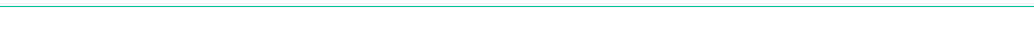
Fig. 4. The single most parsimonious tree generated from maximum parsimony analysis of the four-gene (ITS, TEF1 , TUB2 , and ACT1 ) combined dataset. Numbers in front and after the slash represent parsimony and likelihood bootstrap values from 1000 replicates, respectively. Values represented by an asterisk were less than 70 % for the bootstrap analyses. Ex-type isolates are indicated in bold . Bar indicates the number of nucleotide